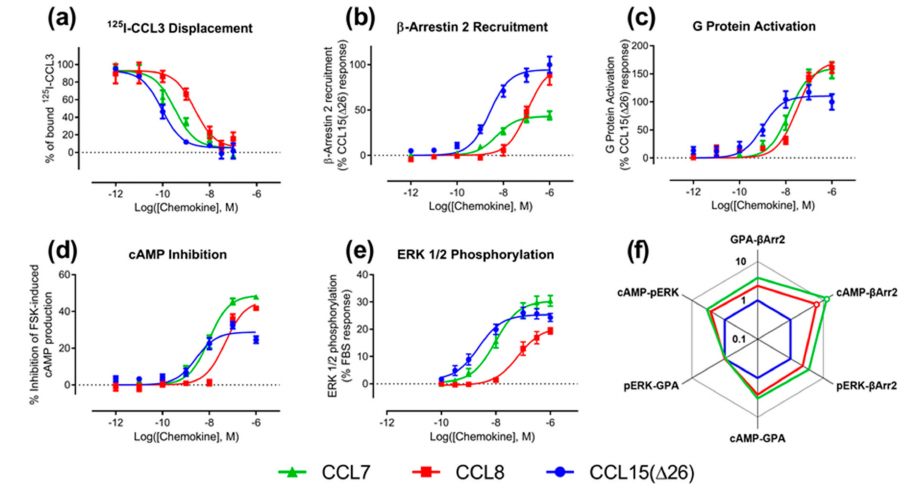
Figure 2. CCR1 binding and activation by wild type chemokines. Each panel ( a – e ) shows the concentration-response data for a di ff erent binding or signaling readout, measured as described in Materials and Methods: ( a ) binding, ( b ) β Arr2 recruitment, ( c ) G protein activation, ( d ) inhibition of forskolin-induced cAMP production, and ( e ) ERK1 / 2 phosphorylation. In panels ( a – e ), data points represent means ± SEM of at least three independent experiments performed in duplicate. ( f ) Web of bias for wild type chemokines at CCR1. Bias factors were calculated as described in Materials and Methods. Each axis represents the 10 ∆∆ (Log( τ / K A)) values comparing the two indicated pathways. Open circles indicate significant di ff erences between values of ∆ Log( τ / K A ) determined at di ff erent pathways for a particular ligand, determined by two-way ANOVA with a Tukey’s multiple-comparison test ( p <